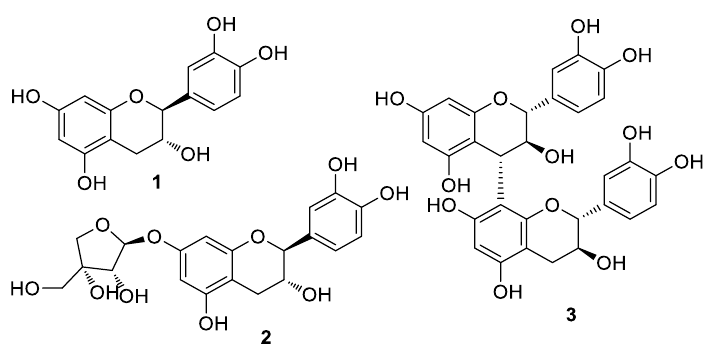
Figure 1. Structure of compounds 1 – 3.